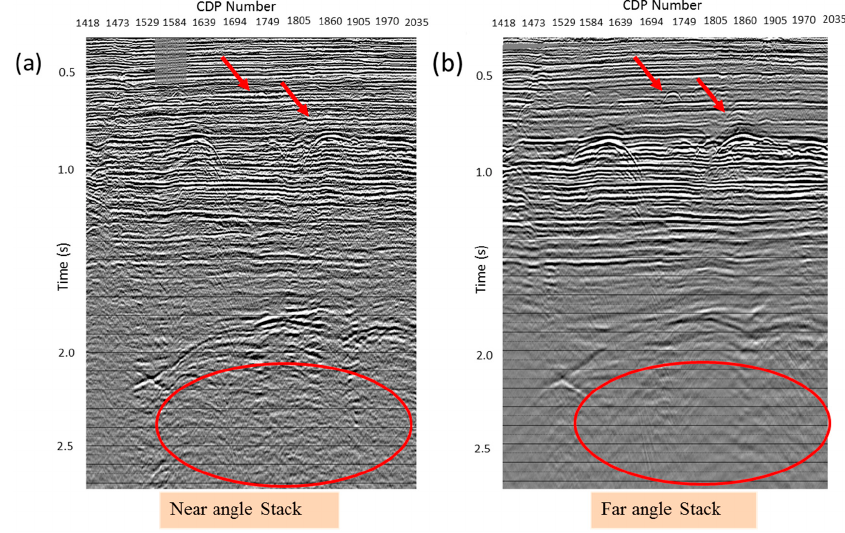
Figure 9. Partial stack seismic with: (a) a near angle stack of 4.5 degree which is almost equal to a zero-offset section, and (b) a far angle stack of 31.5 degrees.